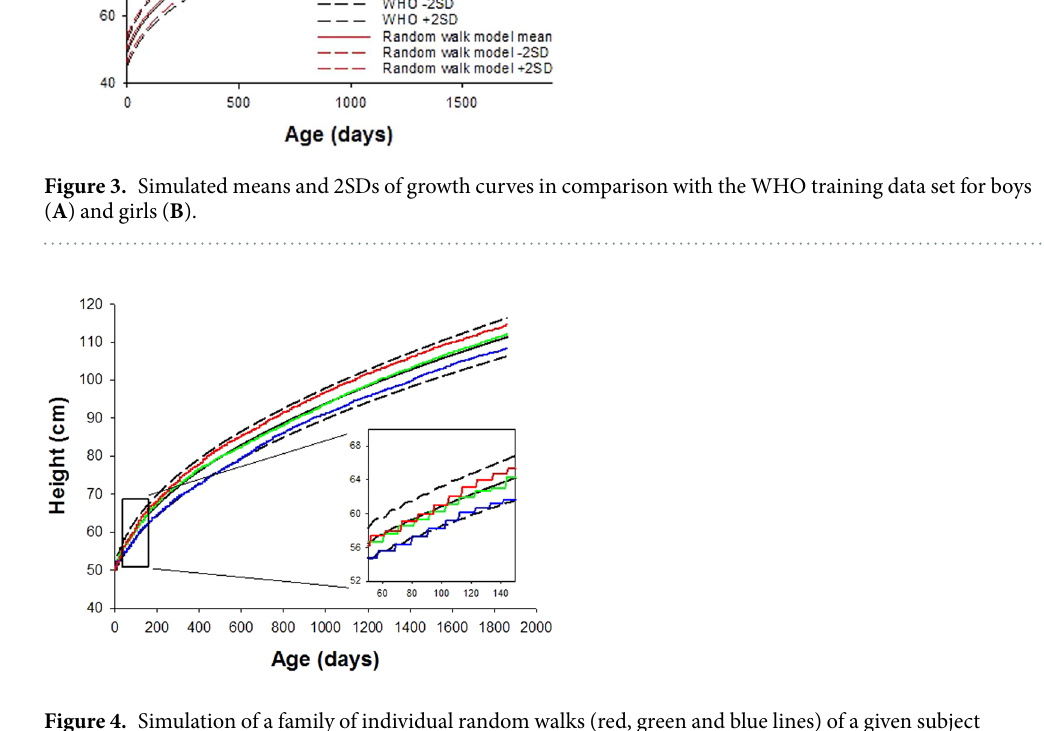
Figure 4. Simulation of a family of individual random walks (red, green and blue lines) of a given subject starting from birth. The probabilistic simulation allows us to calculate the mean (black solid line) as well as confidence intervals ( + SD, black dashed line). The inset shows a magnified region of the growth with the 3 discrete random walk realizations. Note the staircase-like growth curves corresponding to the bursting